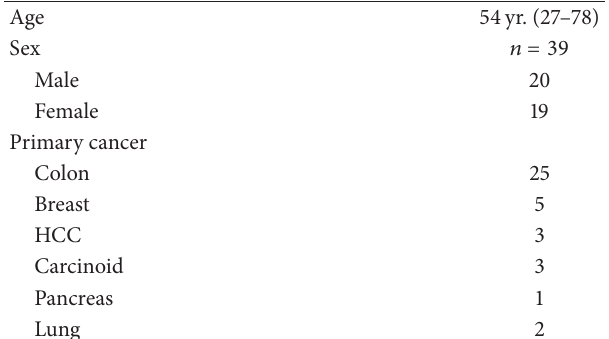
Table 1: Characteristics of patients treated with RE. Table 2: Correlation grading for compatibility of 32 P images obtained by the LEHR collimator and the MEGP collimator,